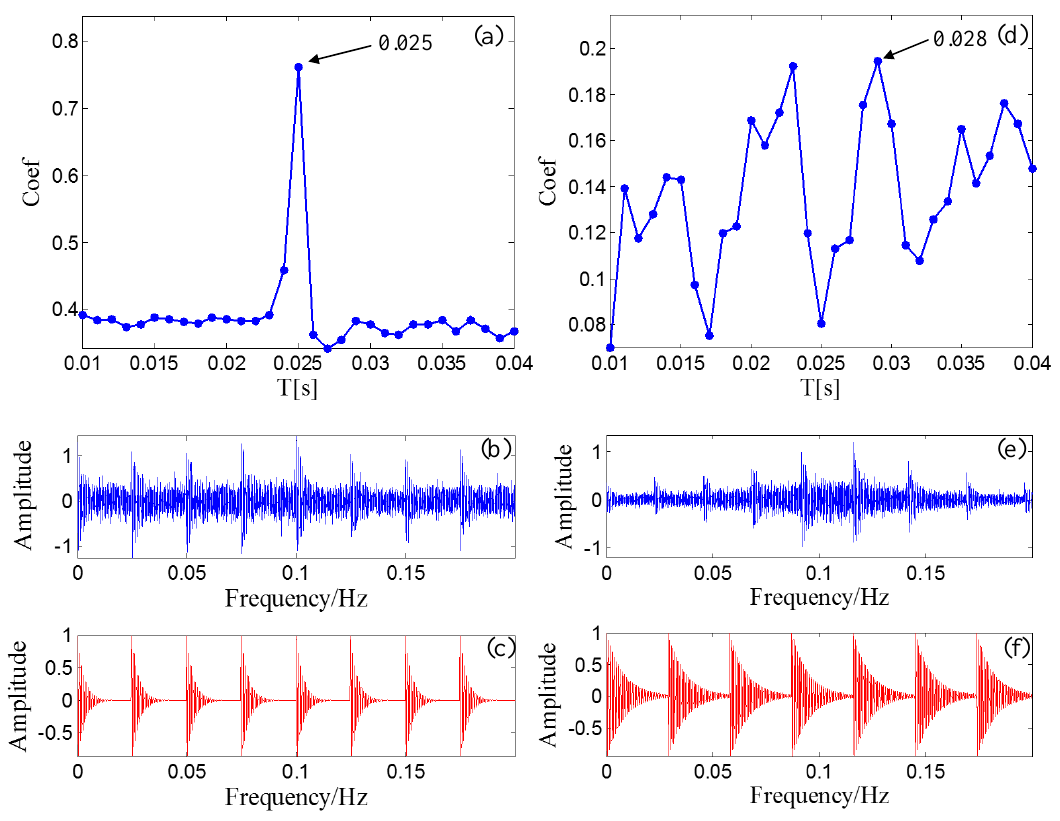
Figure 14. Results for simulated Doppler-shifted bearing signal using the transient model analysis method. ( a ) maximal correlation coefficients for different elements from set T after Doppler effect elimination; ( b ) wave form of the Doppler-free signal; ( c ) the optimal periodical transient model for the Doppler-free signal; ( d ) maximal correlation coefficients for different elements from set T before Doppler effect elimination; ( e ) wave form of the Doppler-shifted signal; ( f ) the optimal periodical transient model for the Doppler-shifted signal.